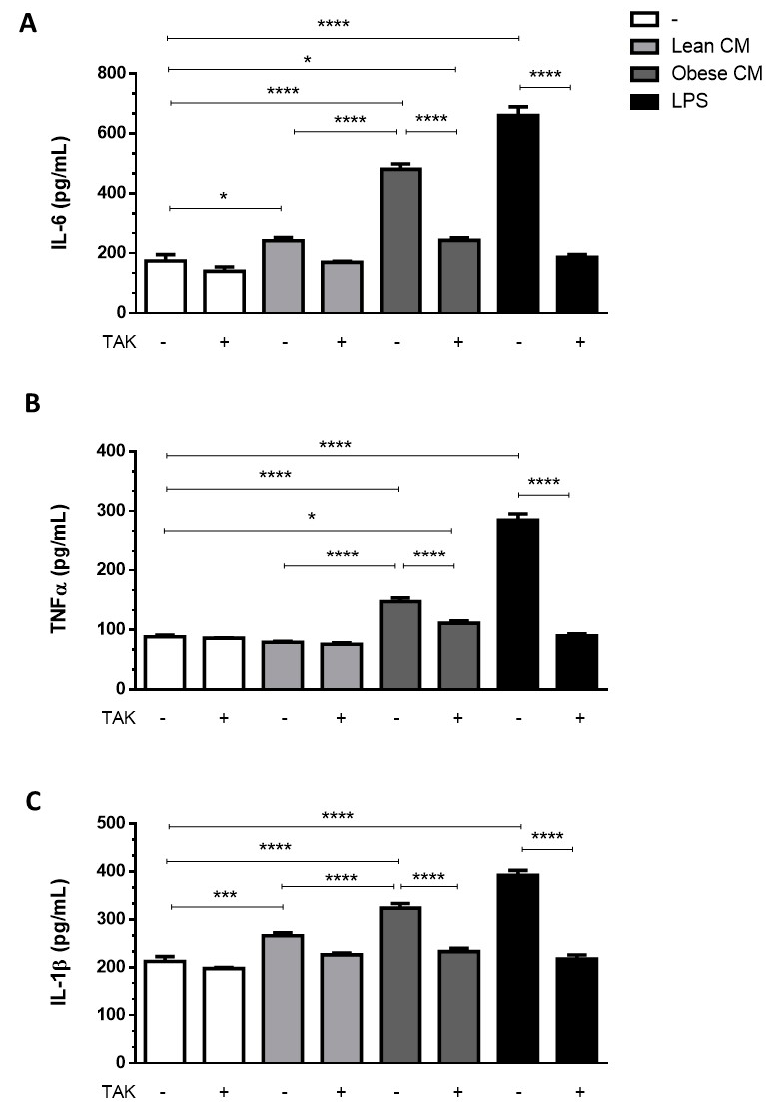
Figure 3. 3T3-L1 cells were left untreated or were pre-incubated with TAK-242 (TAK) 1 μ M for 15 min, at 37 °C/5% CO 2 . After pre-treatment, 3T3-L1 cells were treated or not with Lean Conditioned Medium (CM), Obese Conditioned Medium or LPS 1 μ g/mL for 3 h. Then, the medium was removed, and cells were incubated with DMEM 1% FBS, for 21 h (to complete 24 h). IL-6 ( A ), TNF α ( B ), and IL- 1 β ( C ) were measured in supernatants using a sandwich enzyme-linked immunosorbent assay kit. Results are representative of three independent experiments. Data are expressed as means ± SEM.